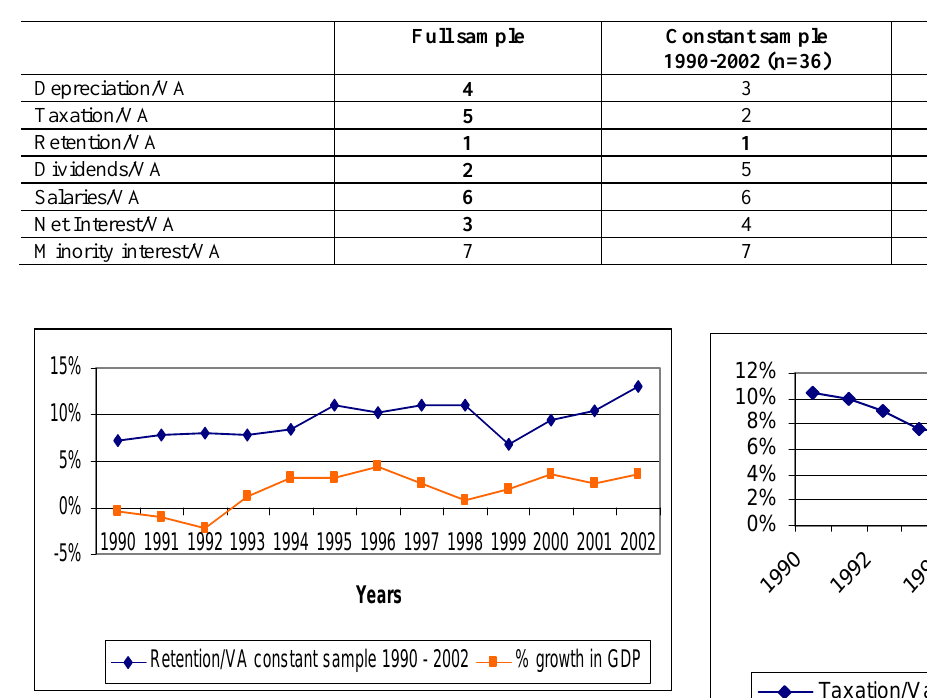
Table 10: Distribution ratios ranked in order from most significant to non-significant according to test statistic of Kruskal-Wallis test